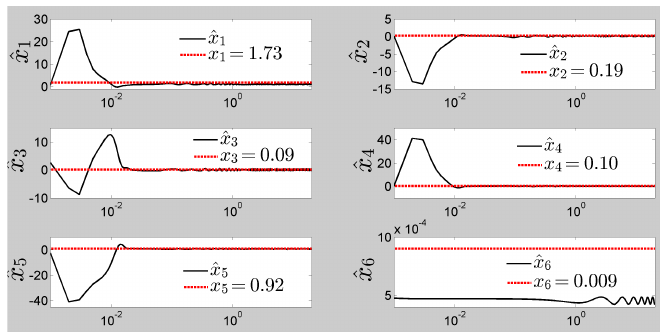
Figure 10. The estimated robot parameters for the tracking